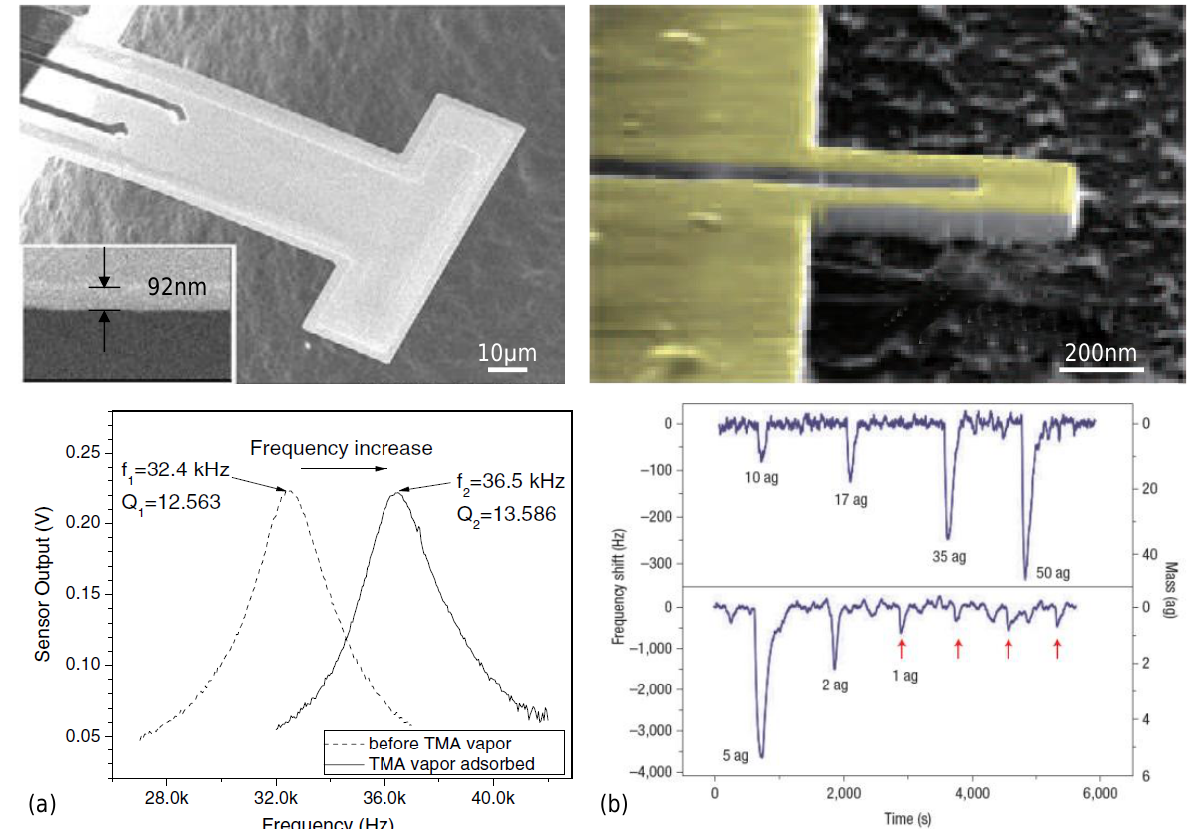
Figure 8. NEMS cantilevers for ultrasensitive gravimetric detection in air. ( a ) A T-shaped nano-thick cantilever with torsional resonant mode ~37.65 kHz exhibits mass sensitivity ~860 Hz/pg, and TMA detection limit <0.1 ppm. ( b ) A SiC nano cantilever with fundamental bending mode in the VHF band (up to 127 MHz), exhibits mass sensitivity ~0.7 Hz/zg, and mass resolution ~0.1 ag. Reprinted with permission from [70,71]. Copyright 2007 Nature Publishing Group, 2010 IOP Publishing Ltd.